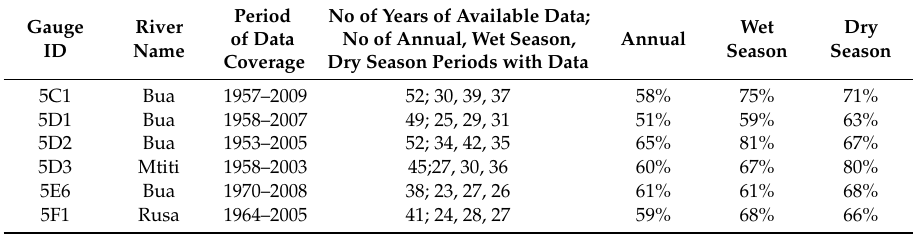
Table 3. Percentage of data coverage in annual and seasonal BFI analysis for the gauges in WRA